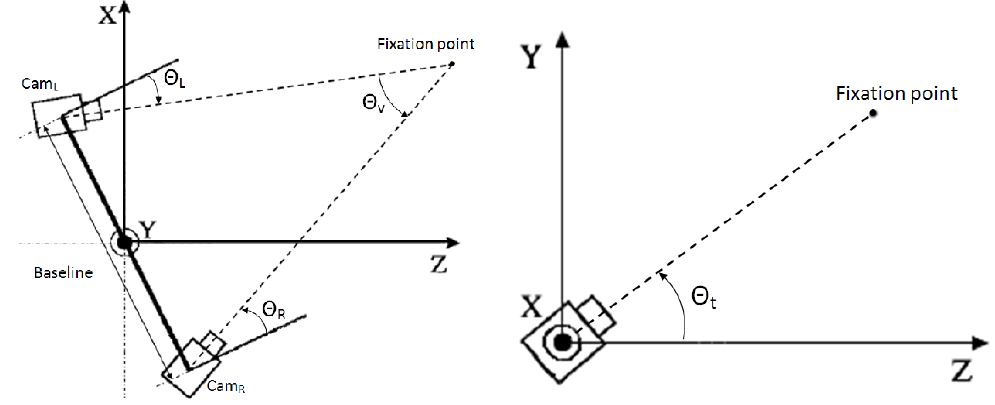
of the camera configuration showing the version, vergence, and tilt angles for each